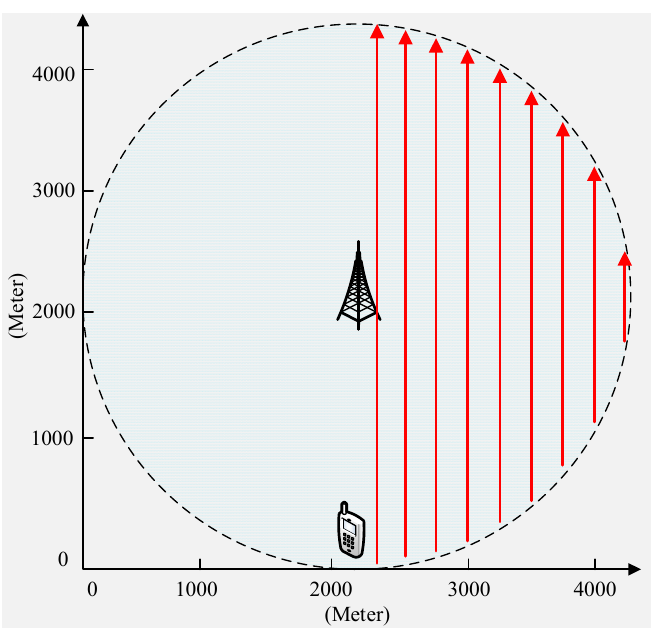
Figure 8. The UE movement path and RSRP are collected as the training dataset. Table 5. The features for the training dataset. Prediction Time Dataset Features